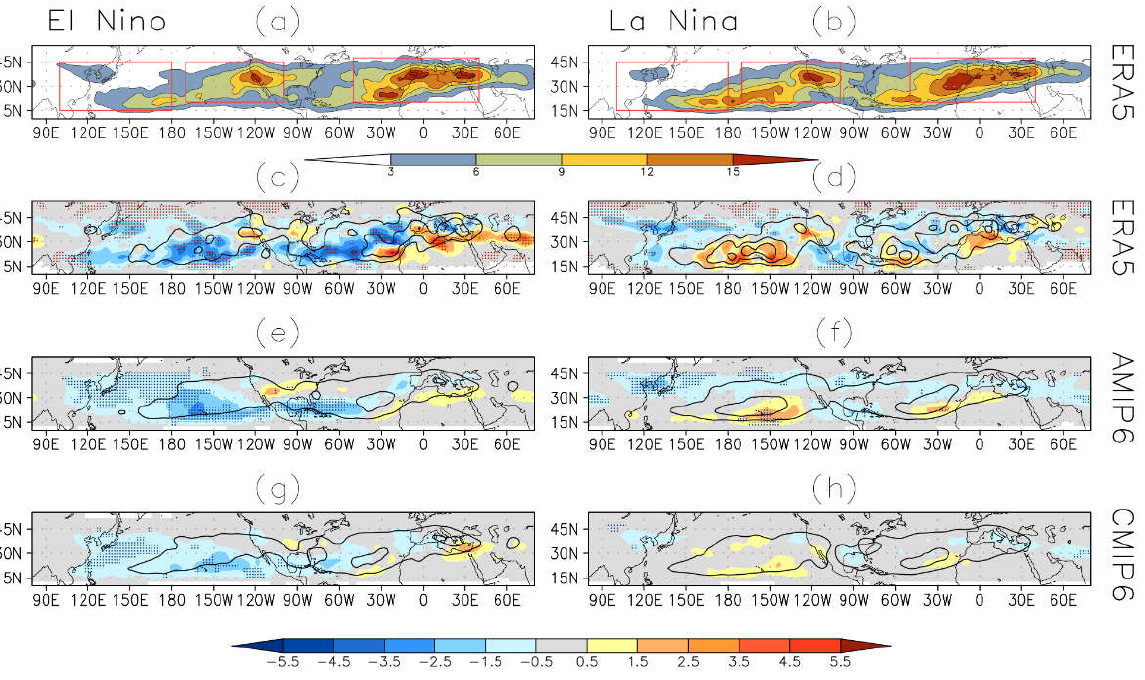
Figure 1. Track density composites of Northern Hemisphere COLs for ( a ) El Niño and ( b ) La Niña in ERA5. Track density anomaly calculated as ( c , e , g ) El Niño and La Niña ( d , f , h ) composites minus the climatology (shaded) combined with genesis density (contour) for ( c , d ) ERA5 and for the multi- model ensemble means of ( e , f ) AMIP6 and ( g , h ) CMIP6. Rectangular cross-hatching regions in ( c , d ) are where statistical significance is >90% confidence level. Stippling areas in ( e – h ) indicate where the anomaly of all models has the same sign. Unit is the number per season per unit area, where the unit area is equivalent to a 5 ◦ spherical cap ( ∼ = 10 6 km 2 ). Genesis density has a contour interval of 1.0 COL per season. All statistics are averaged over all seasons. Red rectangular boxes in ( a , b ) are regions where the cross-wavelet is